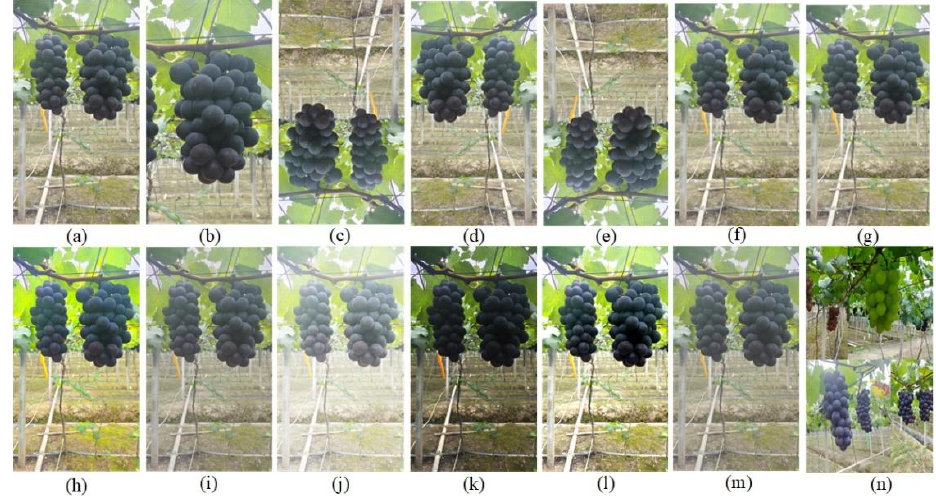
Figure 4. Image augmentation method: ( a ) original image; ( b ) crop and zoom; ( c ) rotate by 180 degrees; ( d ) flip horizontally; ( e ) vertical turnover; ( f ) fuzzy median value; ( g ) Gaussian blur; ( h ) 50% increase in saturation; ( i ) 50% reduction in saturation; ( j ) 50% increase in brightness; ( k ) 50% reduction in brightness; ( l ) 50% increase in contrast; ( m ) 50% reduction in contrast; ( n ) mosaic data enhancement